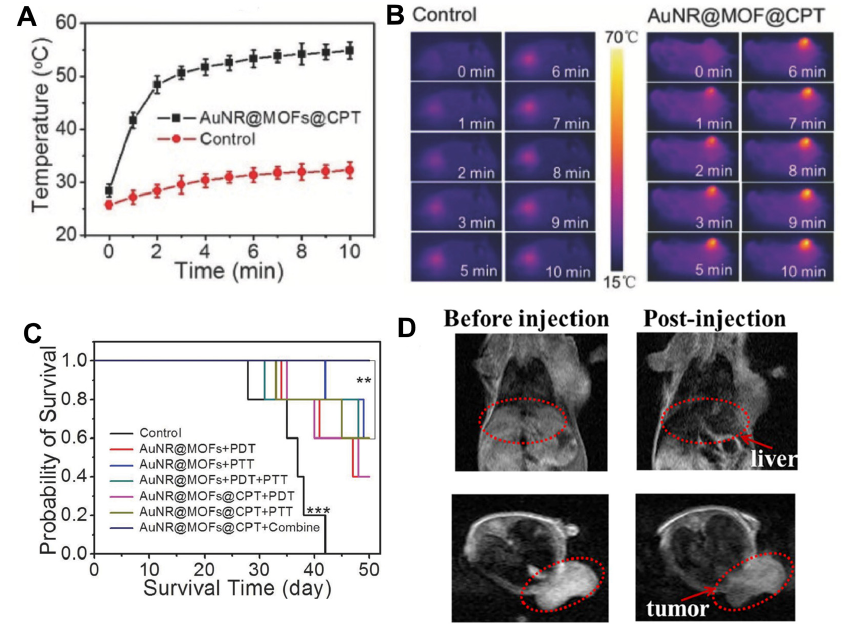
Figure 10. ( A ) Temperature change curve with AuNR@MOF@CPT of tumour tissues as a function of irradiation time. ( B ) in vivo thermal images of the mice after intravenous injection of PBS and AuNR@MOFs@CPT with 808 nm laser irradiation. ( C ) Survival curves of tumour-bearing mice after different treatments with AuNR@MOF@CPT ( n = 5, ** p < 0.01 and *** p < 0.01 were calculated by a Student’s t -test). ( D ) Fe 3 O 4 @C@PCN-222 T 2 -weighted MRI of tumour-bearing mice in the coronal plane (upper) and the axial plane (lower). A red dot line marked the liver region and tumour region. Reprinted/adapted with permission from Ref. [101,102] .